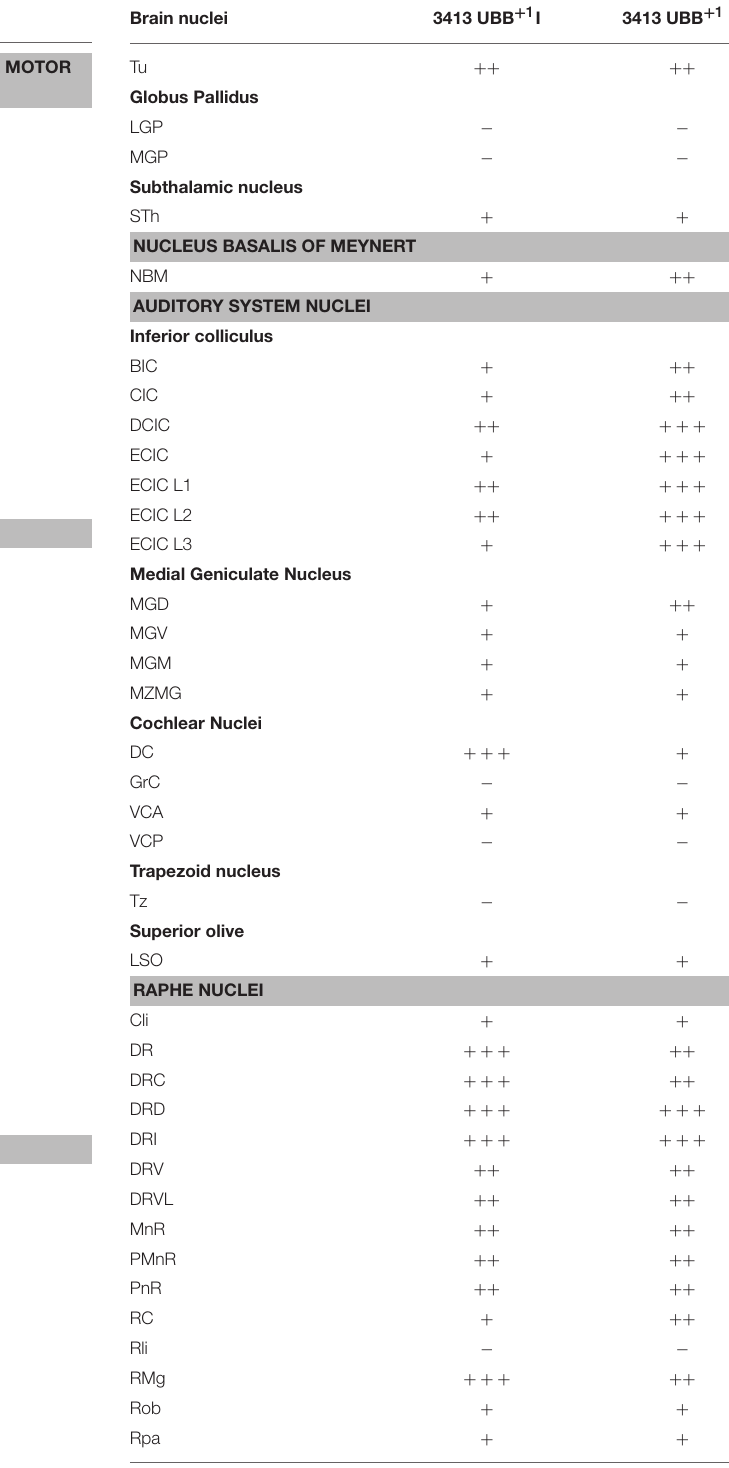
Relative UBB + 1 immunoreactivity scores for intensity and density are illustrated in Figure 2 . No UBB + 1 immunoreactivity was present in any brain regions in the WT mice. − , No immunoreactivity; + , low I or D; ++ , moderate I or D; +++ , high I or D; ++++ , very high I or